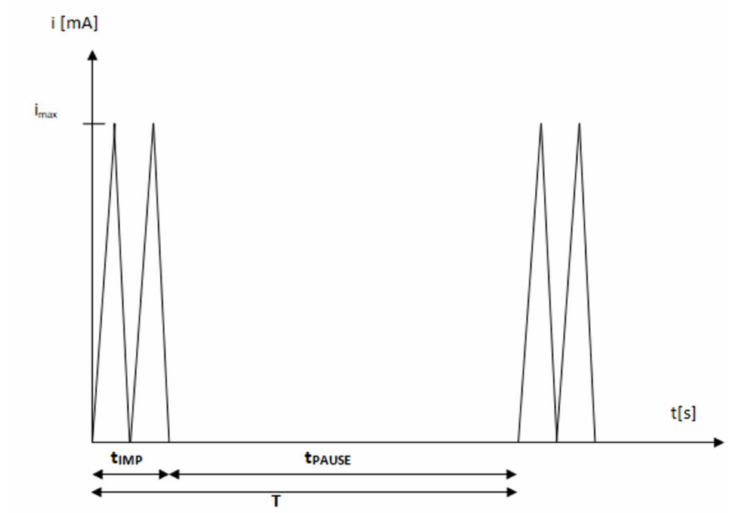
Figure 1. The typical characteristics of waveform in HVES (pulse duration: t IMP = 0.01 T; pause duration: t PAUSE = 0.99 T; period: T = t IMP + t PAUSE ; duty cycle: t IMP